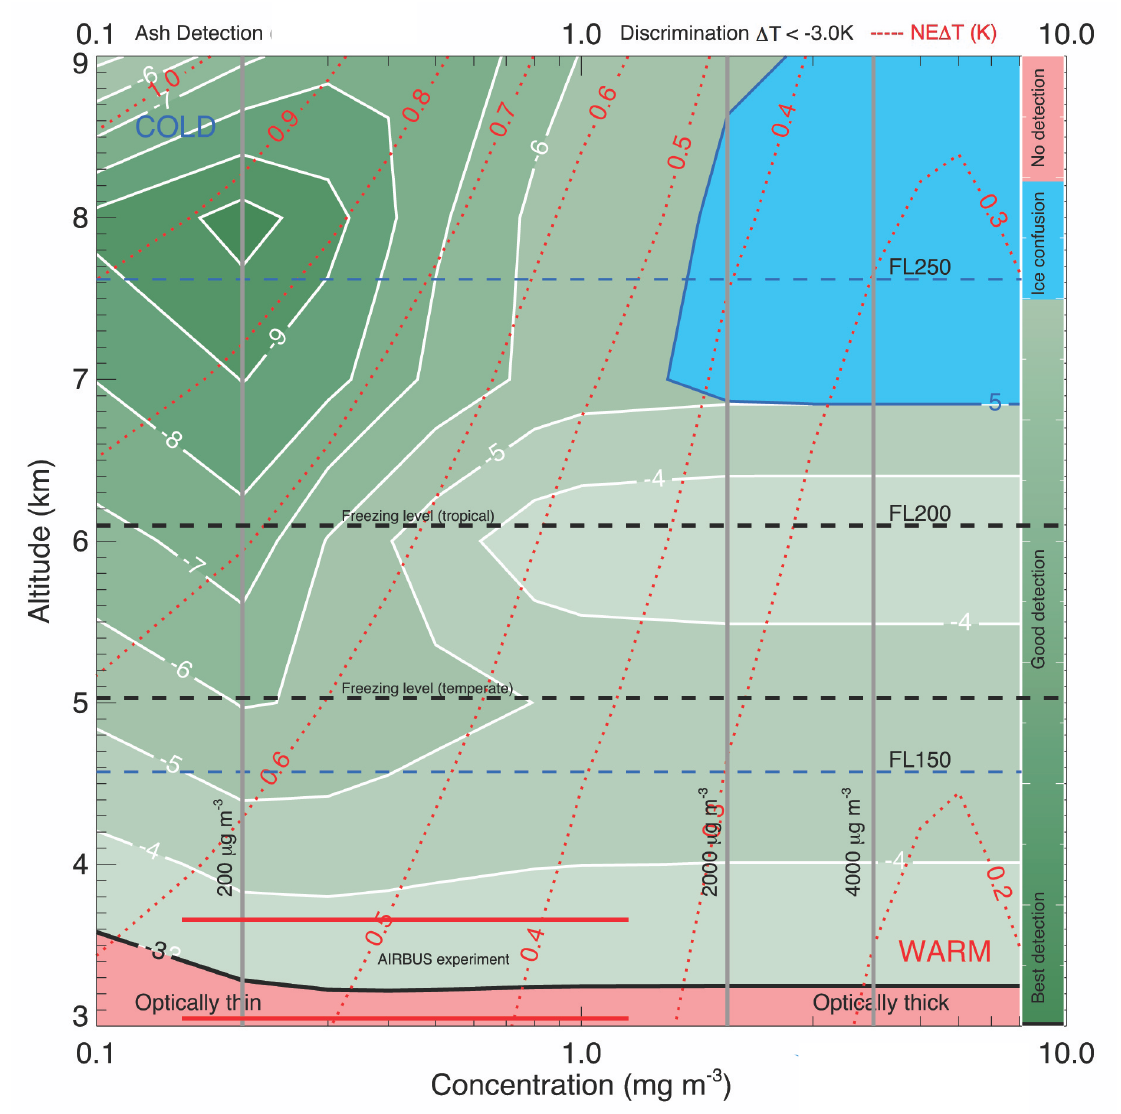
Figure 12. Discrimination against ice. r = 3 µ m, ∆ T = -3 K. The plot shows ash vs. altitude for the optimised (NF). The red-coloured region shows where no detection is possible. The blue-coloured regions are parts of the atmosphere where the system is unable to discriminate ash from ice, that is, these substances appear the same. Green-coloured regions are where ash detection is possible. The red-coloured dashed contour lines indicate the calculated noise temperatures for the algorithm. The white-coloured contours are isolines of ∆ T . A discrimination level of ∆ T = 3 K has − been used (indicated by the black-coloured contour line). Less stringent levels ( ∆ T > 3 K) cause − greater confusion; while more stringent levels compress the region of good detection. The solid red lines show the region of the atmosphere/ash concentration space sampled during the AIRBUS experiment. Three flight levels (FL) are shown and the locations of the freezing level is shown for a tropical and temperate